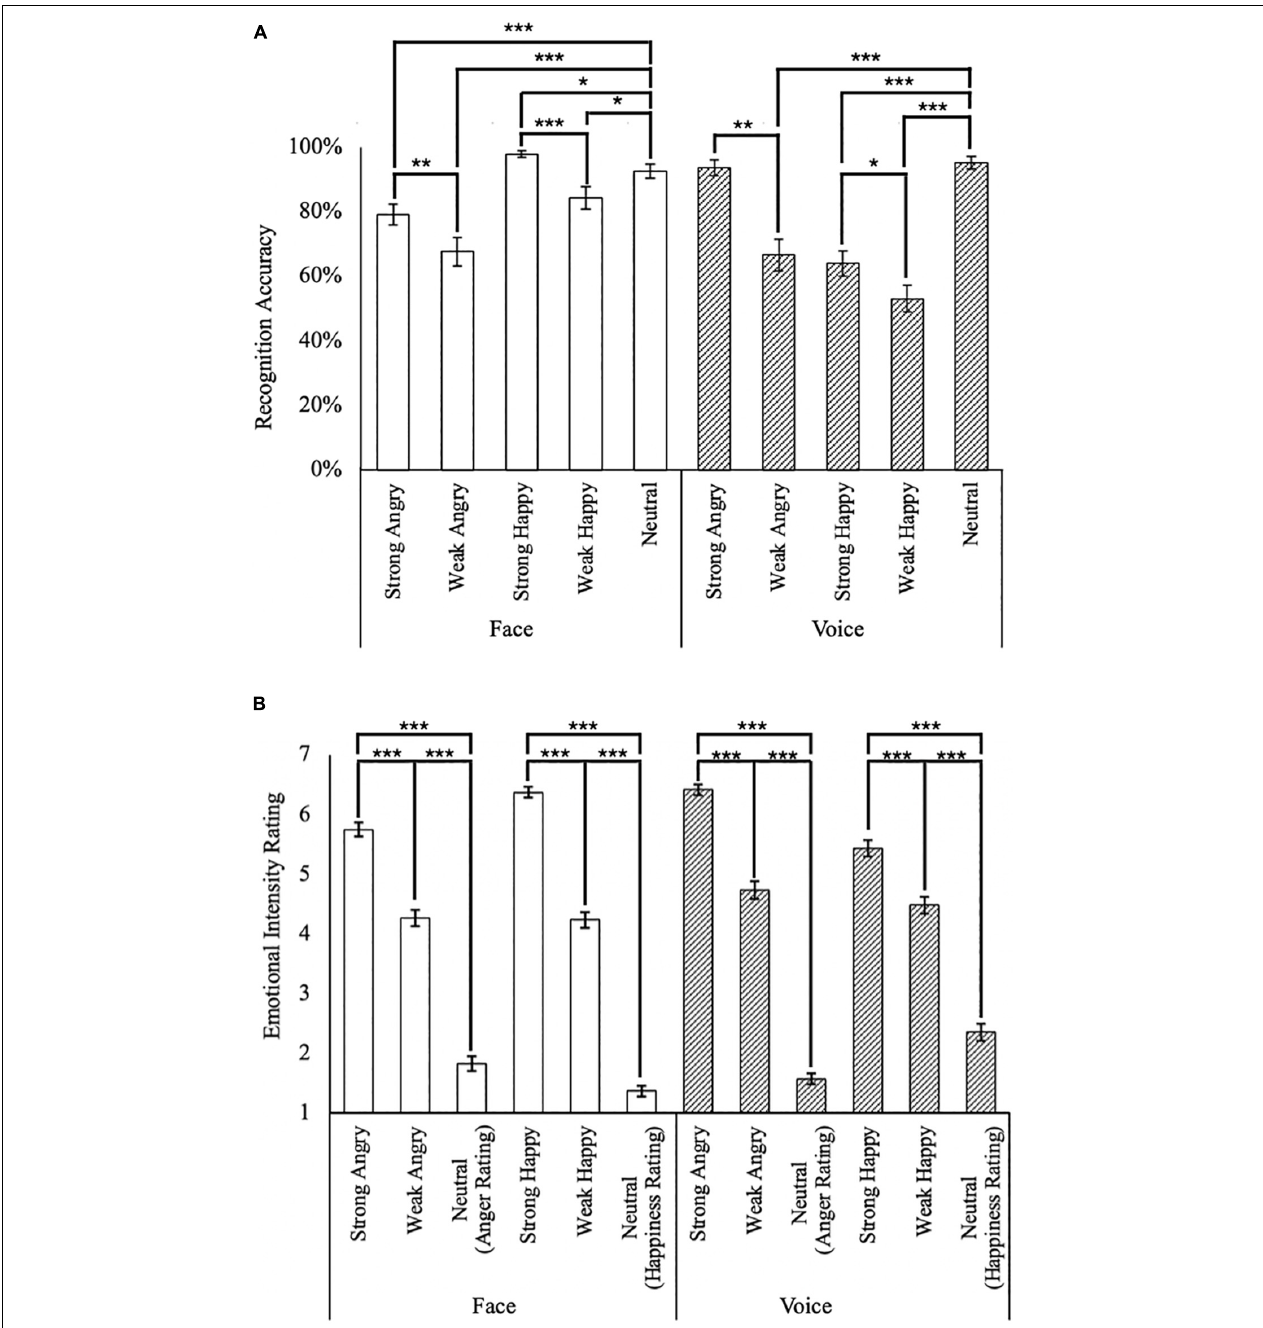
FIGURE 2 | Summary of behavioral responses. (A) Emotion recognition accuracy for face (white bars) and voice (hatched bars); and (B) unisensory emotional intensity rating. * p < 0.05, ** p < 0.01, *** p < 0.001. The error bars indicate standard errors of mean (SEM).